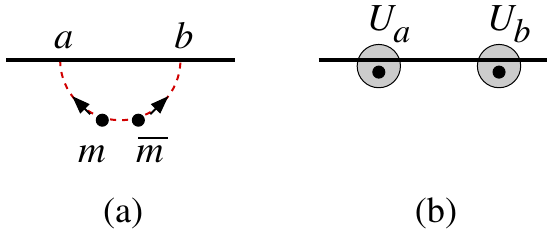
FIG. 3. (a) For each m 2 M , we can consider a process in which we create a pair of quasiparticles m , (cid:3) m in the bulk, move them along some path (cid:10) to two points on the edge, and then annihilate them. We define W m(cid:10) to be the operator that imple- ments this process. (b) To establish condition (1) of the criterion, we consider two paths (cid:10) , (cid:11) , and two associated operators W m(cid:10) , W m 0 (cid:11) . We then make use of the relations (18) and (19) along with the commutation relation